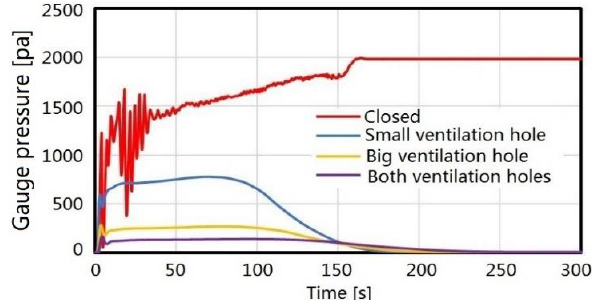
Figure 9. Pressure with different ventilation levels.